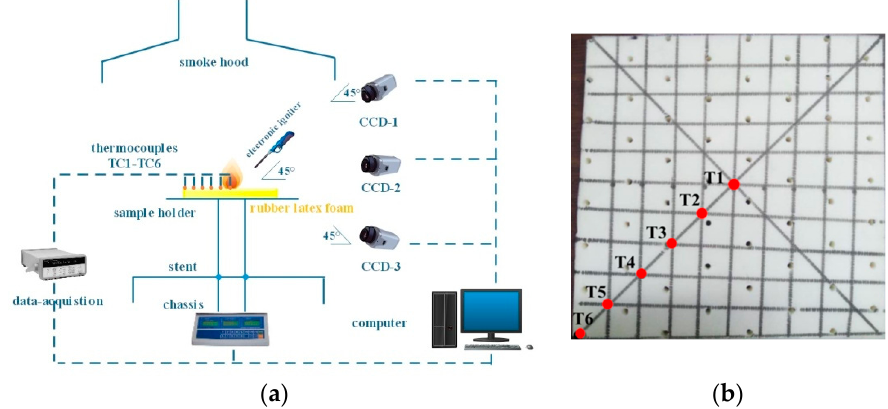
Figure 3. ( a ) Schematic of small-scale platform in this study; ( b ) Tested rubber latex foam sample and thermocouples positioned along the horizontal direction (T1 to T6).